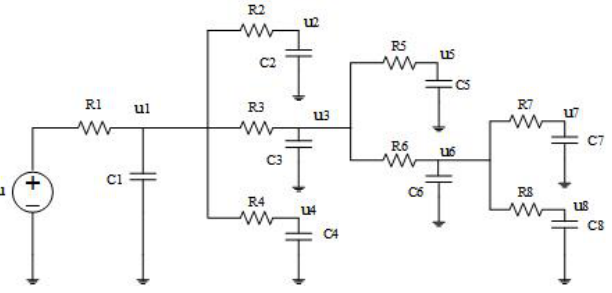
Figure 1. Clock network structure of an 8-bit adder